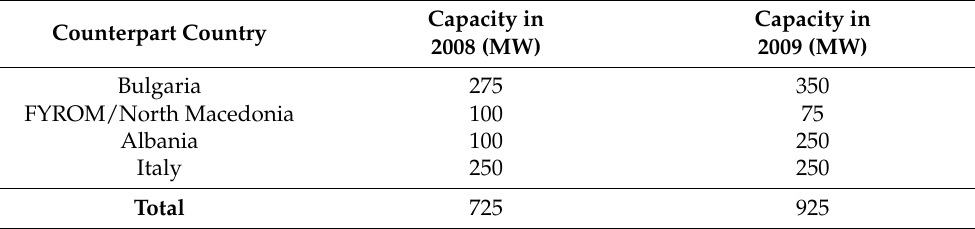
Table 2. Maximum availability of energy import and connection points.